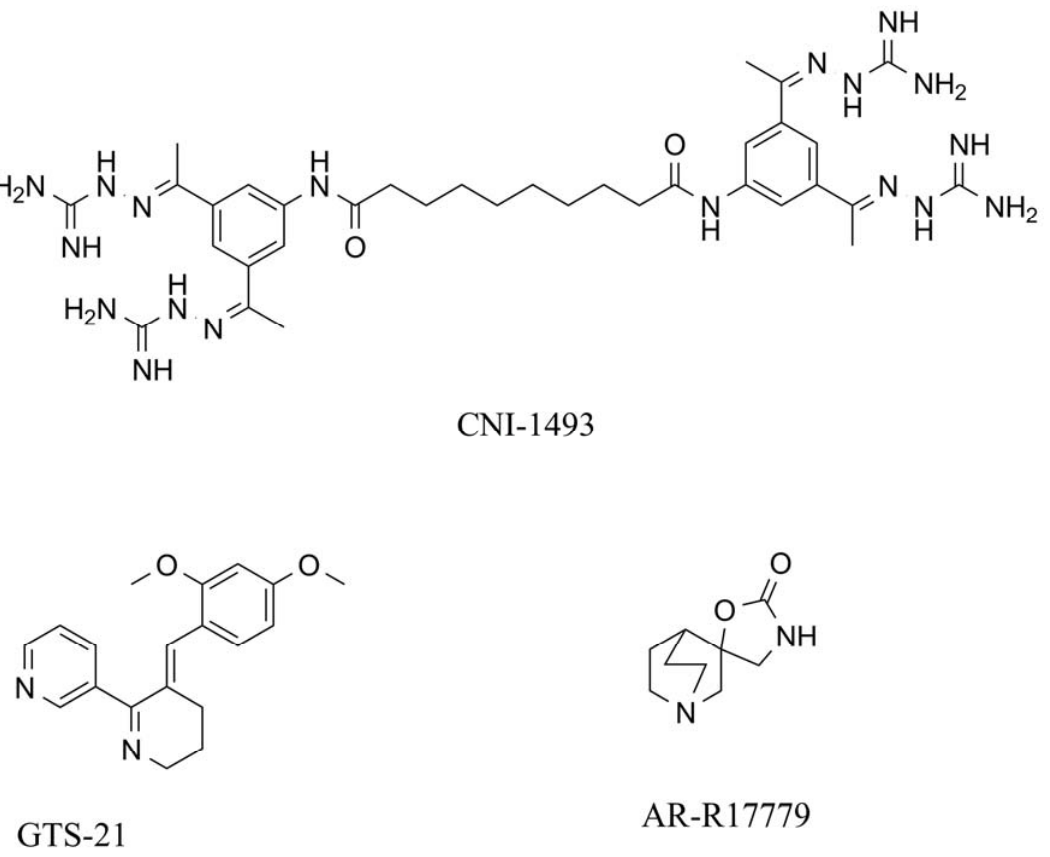
Figure 5. Structures of α 7 nAChR agonists with significant anti-inflammatory